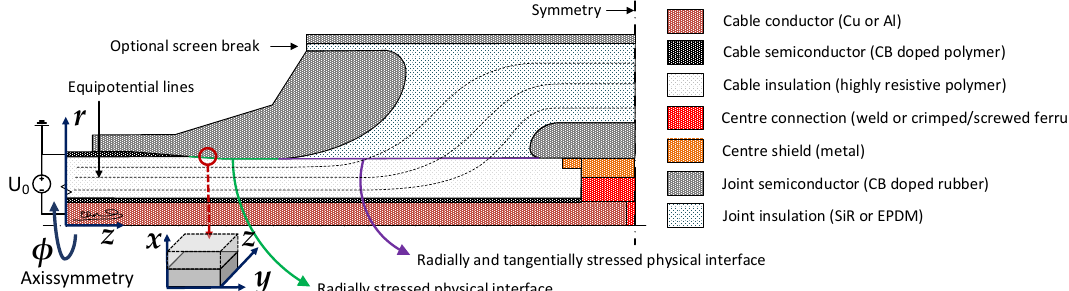
Figure 1. Schematic structure of a cable joint. Additional layers providing water blocking, mechanical strength, etc. are not shown. The physical interface studied in this work is indicated by the red circle. Note that for the sake of simplicity, the axisymmetric coordinates ( r, φ , z ) at the micro-scale are replaced by Cartesian coordinates ( x, y, z ). In addition, any interstitial material (grease, oil, etc.) is considered as a part of the electrode, owing the low conductivity in XLPE.